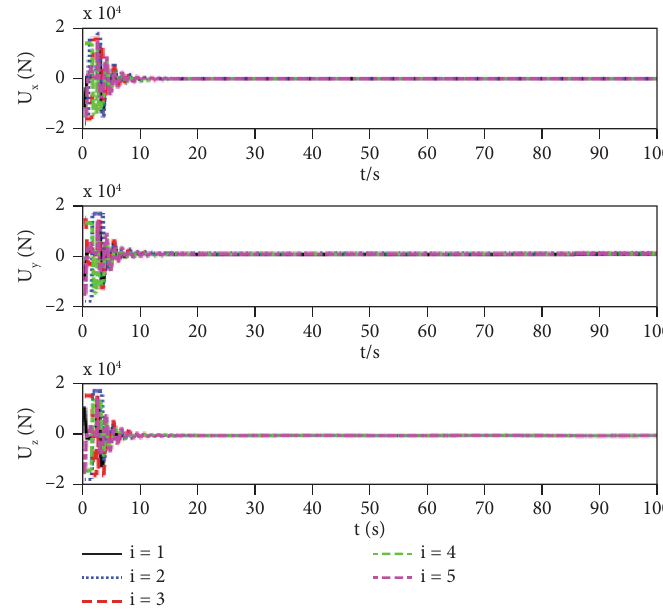
Figure 7: Missile control